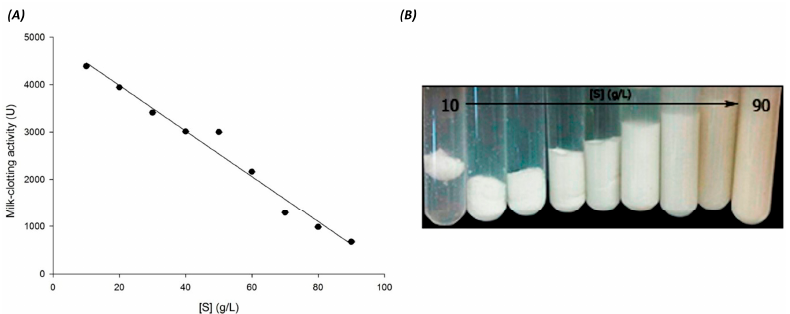
Figure 3. Substrate concentration effect on skimmed milk-clotting activity of seed extract. ( A ): Left plot was drawn using the data obtained from the milk-clotting activity assay. ( B ): Right image shows the curd formation in test tubes. One unit of milk-clotting activity (MCA) is defined as the amount of enzyme to clot 1 mL of a solution containing 0.1 g skim milk powder in 40 min at 35 °C. Substrate concentration is expressed as [S]. All experiments were performed in triplicate, and each data point represents the means of at least three determinations. The regression line equation is (y = − 48.03x + 4941.39) with a correlation coefficient of R = 0.99.